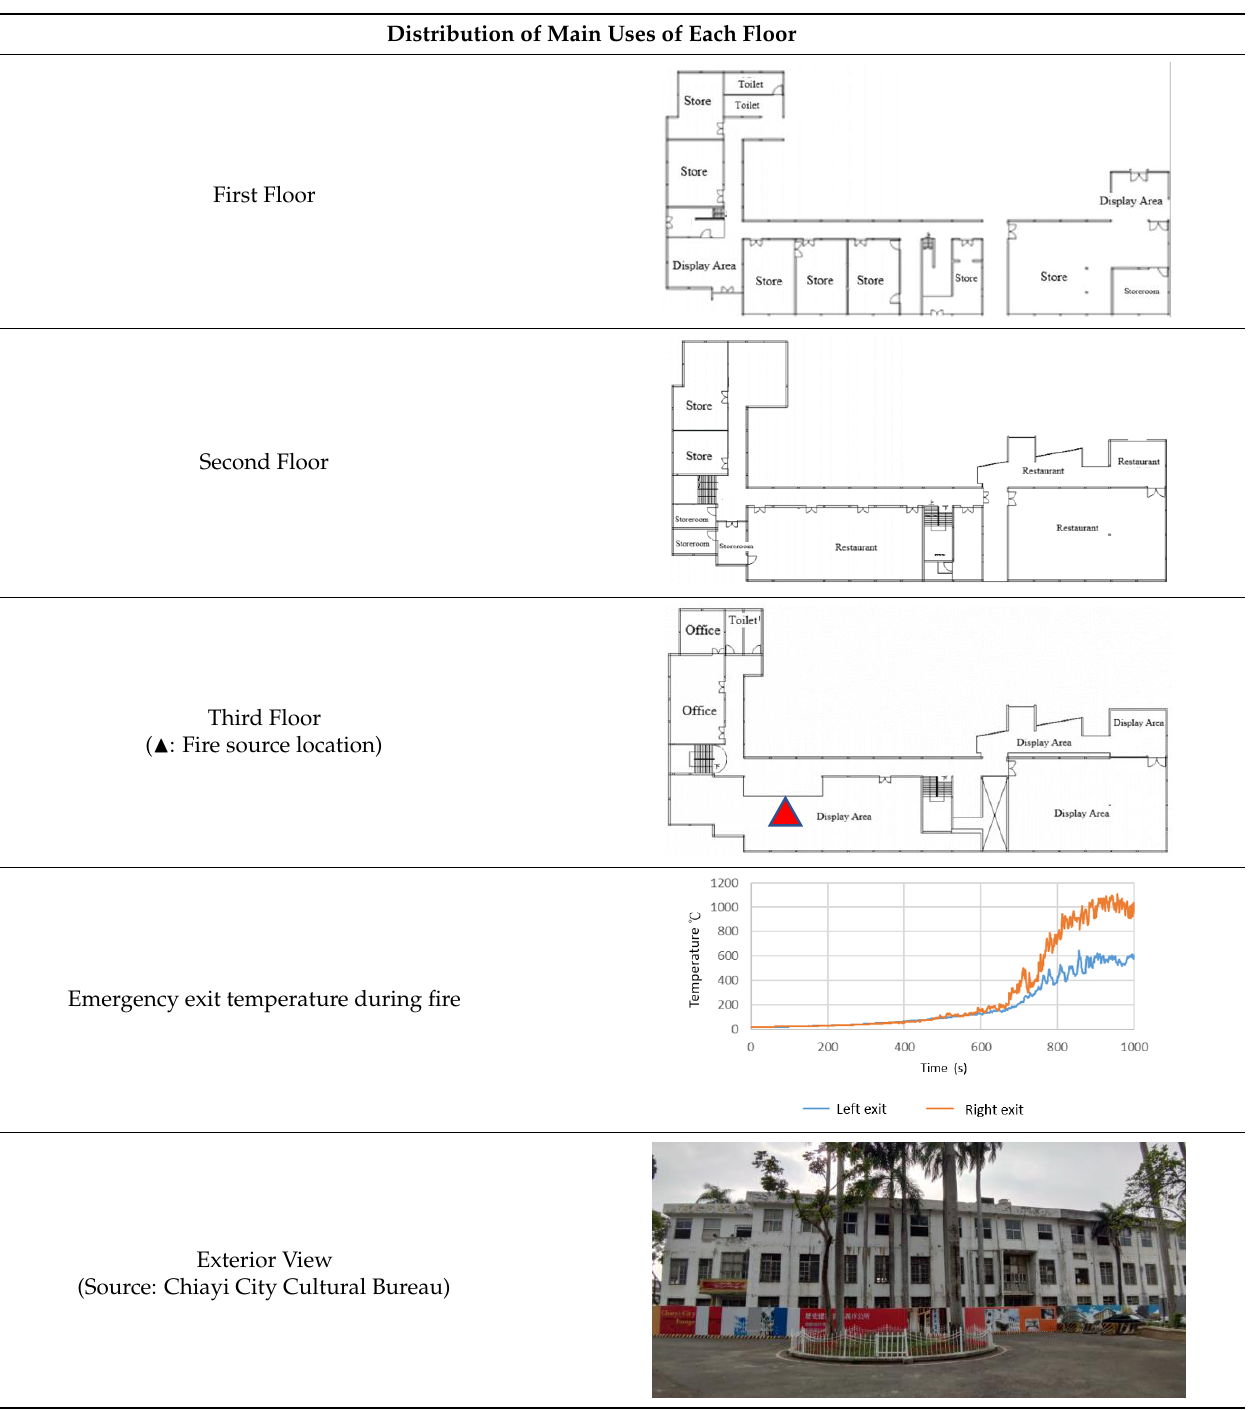
Table 1. Distribution of primary uses of each floor.